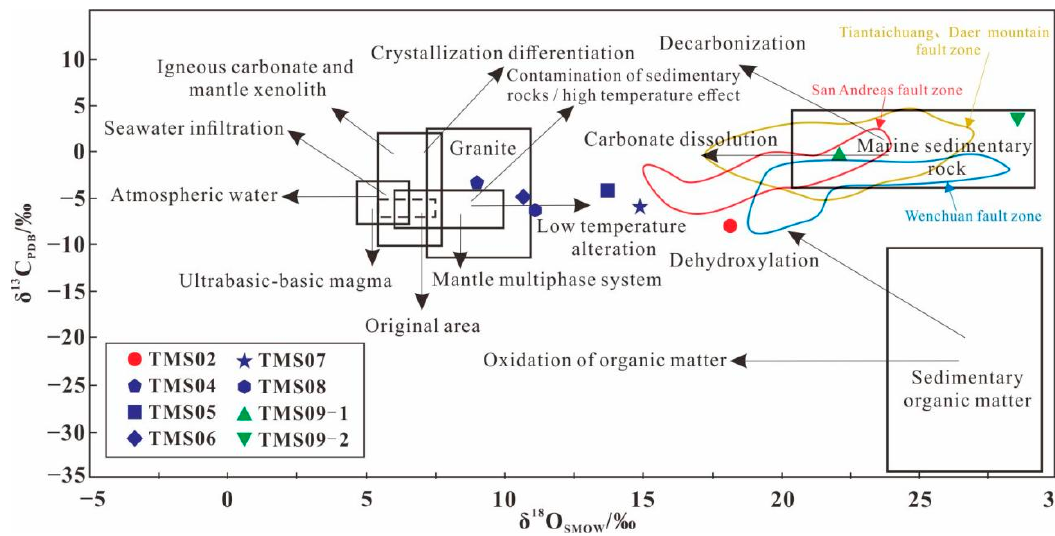
Figure 6. Carbon and oxygen isotopic characteristics of fault gouge and host rock in the Tamusu area [41].